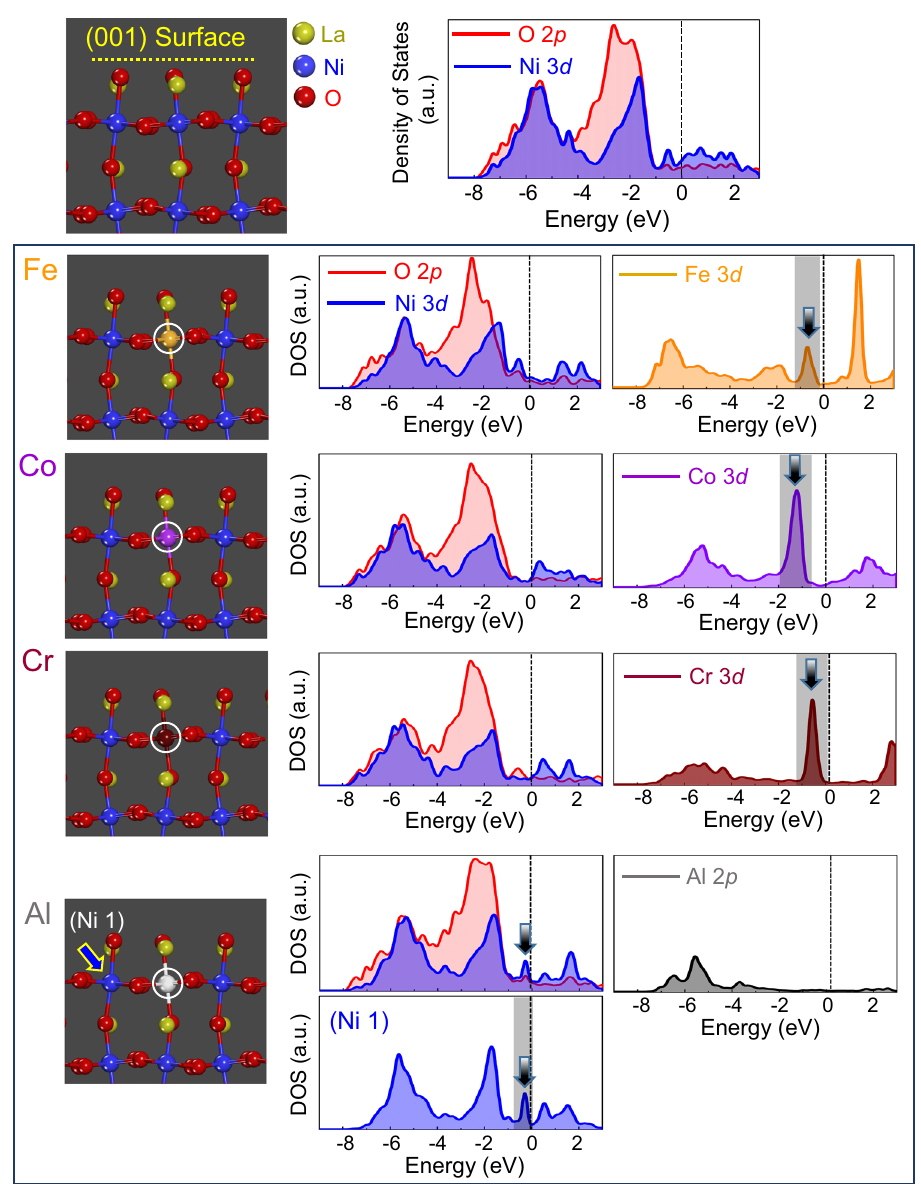
Fig. 1 DOS at the LaNiO 3 (001) cubic surface with various dopants (1). The fi rst set of DOS plots for O 2 p , Ni 3 d , and metal 2 p or 3 d states is provided for each case. A black arrow together with a gray shadow in each plot indicates the noticeably high density of the 3 d states near the Fermi level. It is noteworthy that a rise of the 3 d states of Ni-1 is induced by Al doping, although Al does not provide a signi fi cant contribution to the total DOS between − 2 and 0